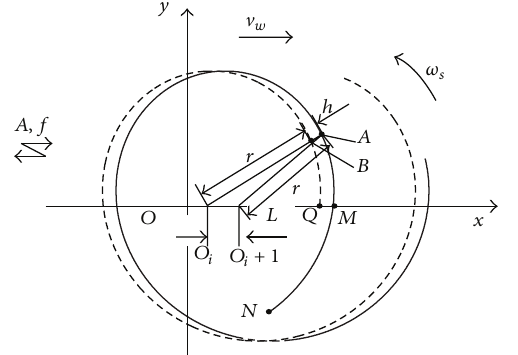
Figure 2: Geometrical schematic of instantaneous abrasive cutting thickness.